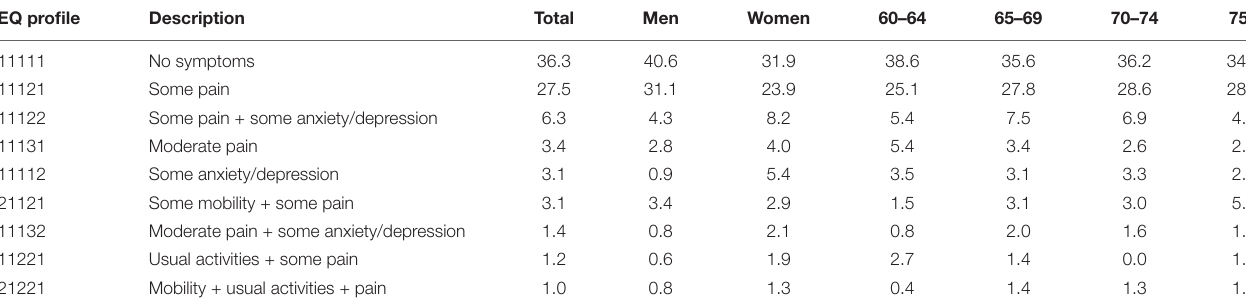
TABLE 4 | Most frequent quality of life profiles.